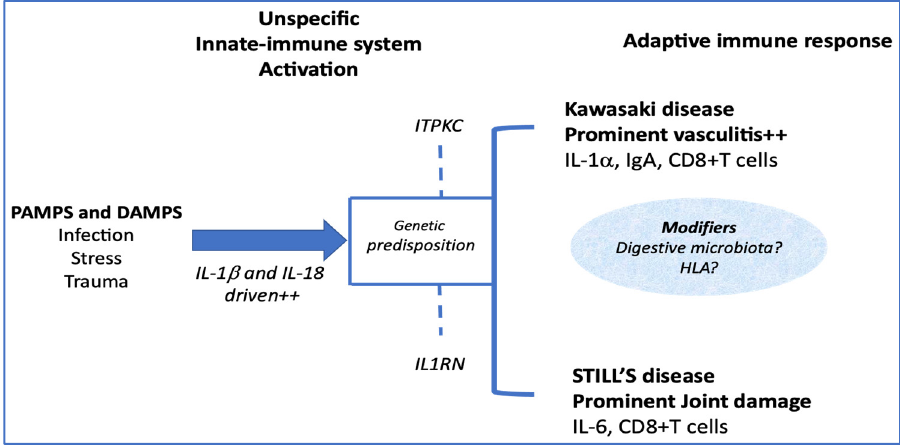
Figure 2. Modifiers that tip the immune response towards one clinical form or